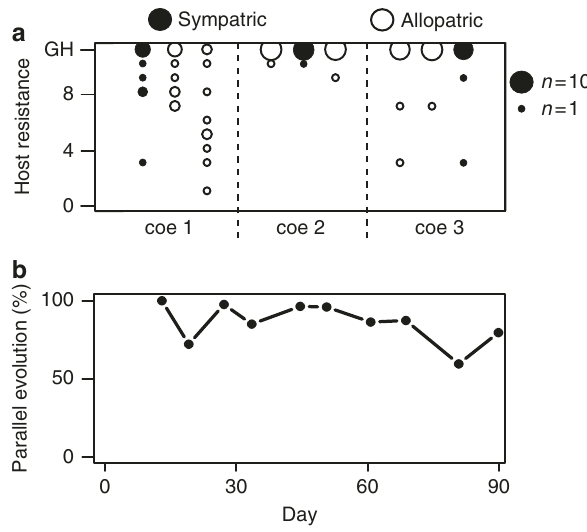
0 Fig. 2 Phenotypic parallel evolution. a Host resistance (ranging from susceptible = 0 to general resistant host = GH) of 10 algal clones per replicate of the coevolved populations. Algal hosts were isolated from day 90 and for every replicate population and host resistance were tested to all virus types (isolated from 11 time-points, ranging from day 0 to day 90) from their own replicate (sympatric host – virus combination) and to all virus types form the other two replicates (allopatric host – virus combinations). The size of the dots correlates with how many hosts had that particular resistance range (total of 10 host clones per replicate, smallest dot size in fi gure equals to one host clone). Most algae were general resistant (sympatric host – virus combinations) and hosts that were general resistant were also general resistant when tested against all virus populations of the other replicates (allopatric host – virus combinations). b Degree of parallel evolution between the three replicates of the coevolved populations. Parallel evolution was calculated for 10 time-points ranging from day 12 to day 90. Hosts of the three replicate coevolved populations evolved in a highly parallel way over time (average = 87%; coe1 – coe3 correspond to Fig.